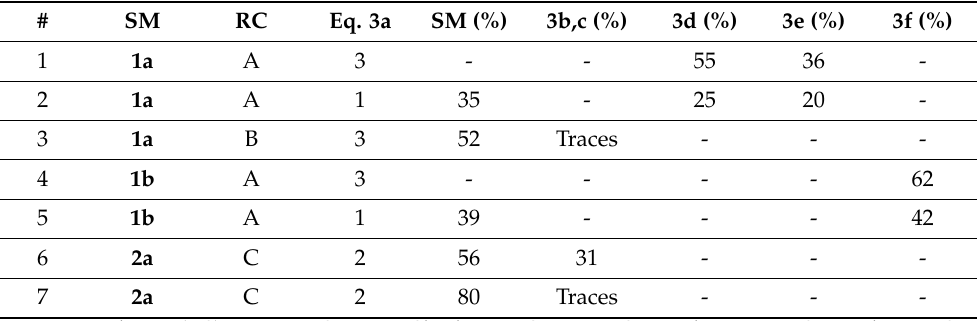
Table 1. Reaction conditions and yields of hydroxylamines 3b–f .